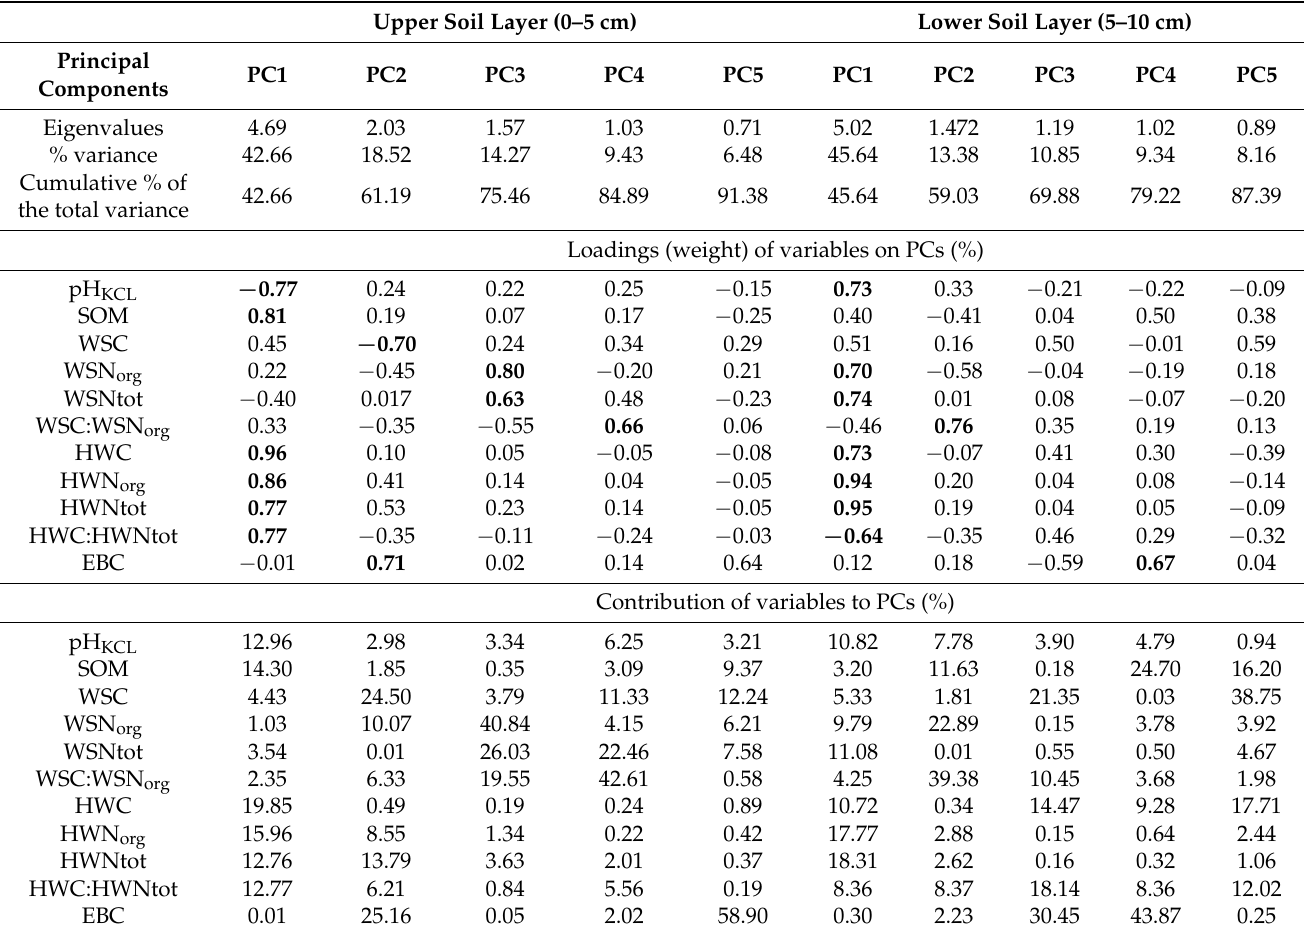
Table 2. Principal component analysis (PCA) of 11 selected soil chemical properties measured in 108 samples under nine treatments (tree species) at two soil layers. Variable loadings higher than 0.6 are in bold, expressing a significant weight of variables on PC, and the first five principal components explaining 87%–91% of the cumulative total variance are presented. The sign on variable loadings indicates the direction of the variable on PC axes. Analyzed soil variables (pH; SOM = soil organic matter; EBC = exchangeable basic cations; WSC = water-soluble C, WSN org = water soluble organic N; WSNtot = water-soluble total N, WSC:WSN org = water soluble organic C/N ratio; HWC = hot water-extractable C, HWN org = hot water-extractable organic N, HWNtot = hot water-extractable total N, and HWC:HWNtot= hot water- extractable C/N